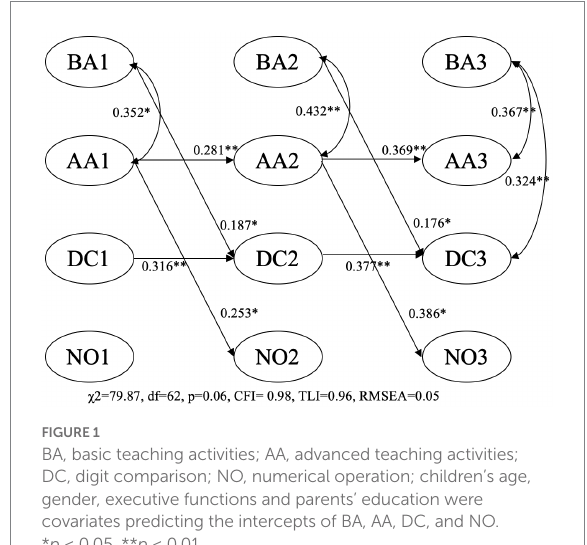
FIGURE 1 BA, basic teaching activities; AA, advanced teaching activities; DC, digit comparison; NO, numerical operation; children’s age, gender, executive functions and parents’ education were covariates predicting the intercepts of BA, AA, DC, and NO. * p < 0.05, ** p < 0.01.